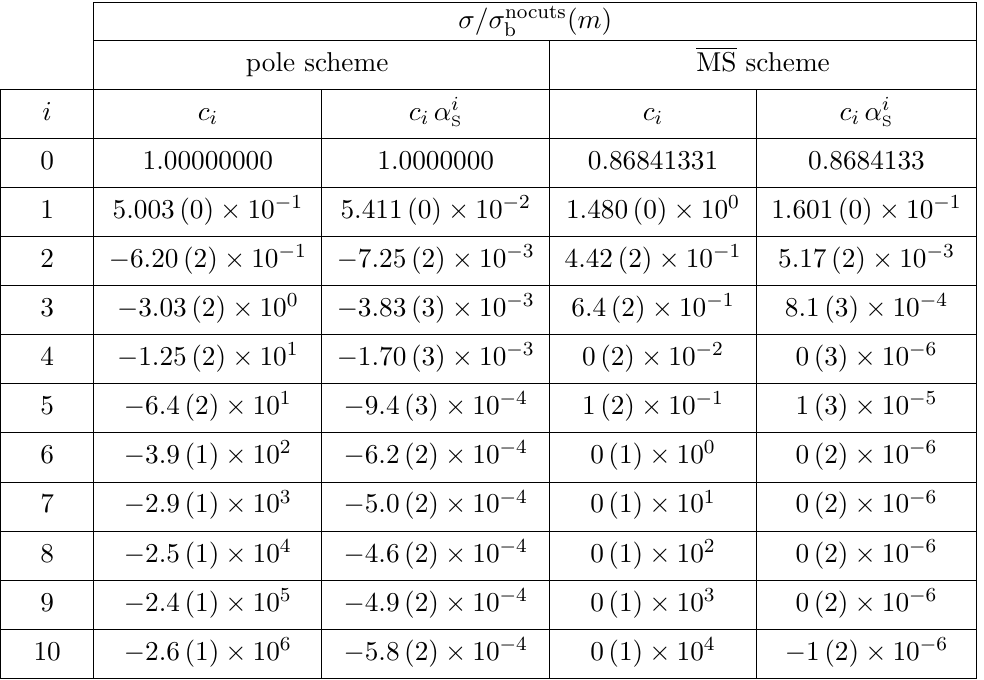
Table 3 . Coe(cid:14)cients of the (cid:11) expansion (8.4) of the inclusive cross section to all orders, computed S in the large- b 0 approximation, normalized to the total Born cross section computed in the pole-mass scheme. The errors reported in parenthesis are due to the uncertainty on the linear coe(cid:14)cient of the (cid:12)t (i.e. p 1 in eq.